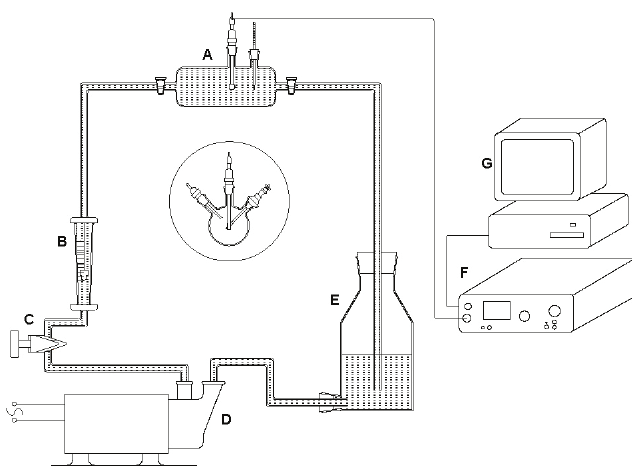
Fig. 1 – Equipment for electrochemical measurement under flow regime: (A) flow-through cell with three electrodes, (B) flowmeter, (C) valve, (D) pump, (E) vessel, (F) potentiostat, and (G) computer